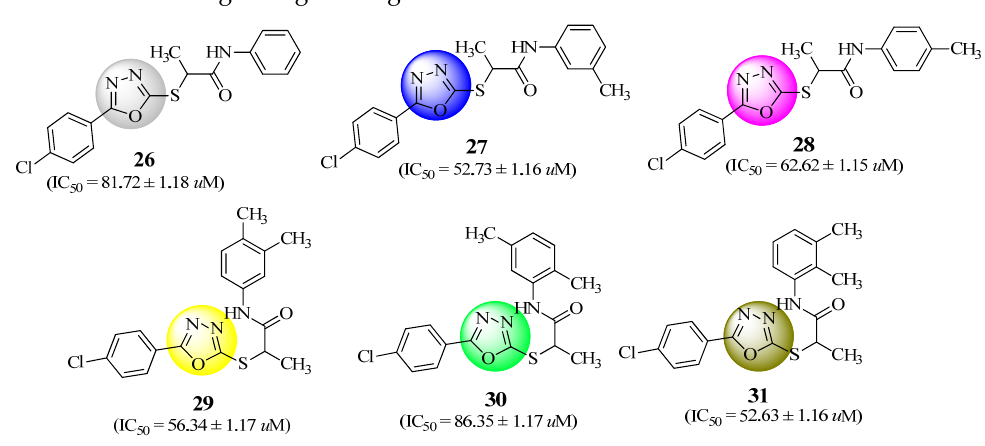
Figure 17. Oxadiazole derivatives with strong α -glycosidase inhibitory activity.